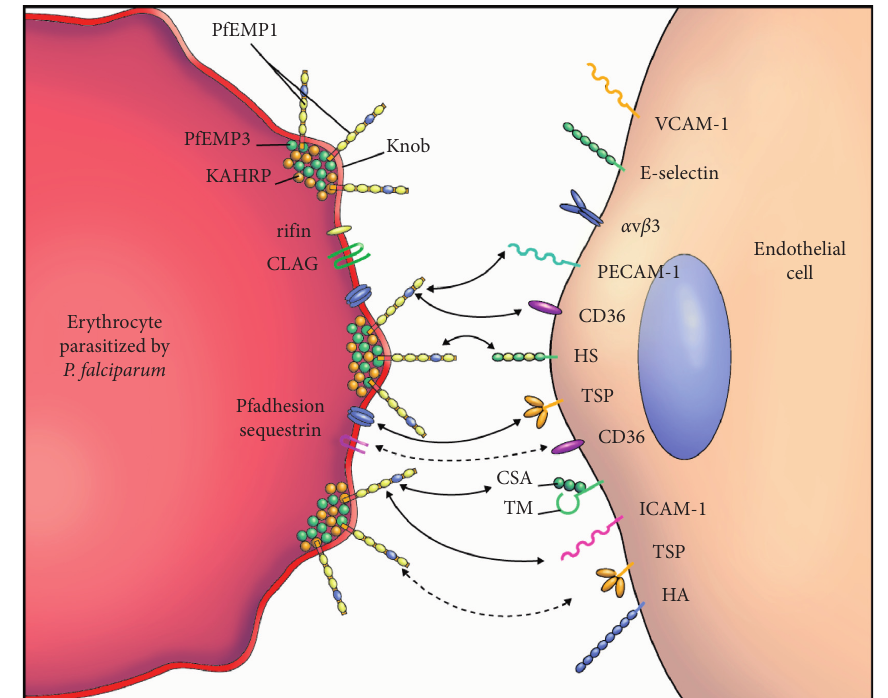
Figure 3: Falciparum cytoadherence (VCAM-1: vascular cell adhesion molecule-1, α v β 3: integrin, PECAM-1: platelet endothelial cell adhesion molecule-1, HA: hyaluronic acid, CLAG: clag9 ligand) (adopted from